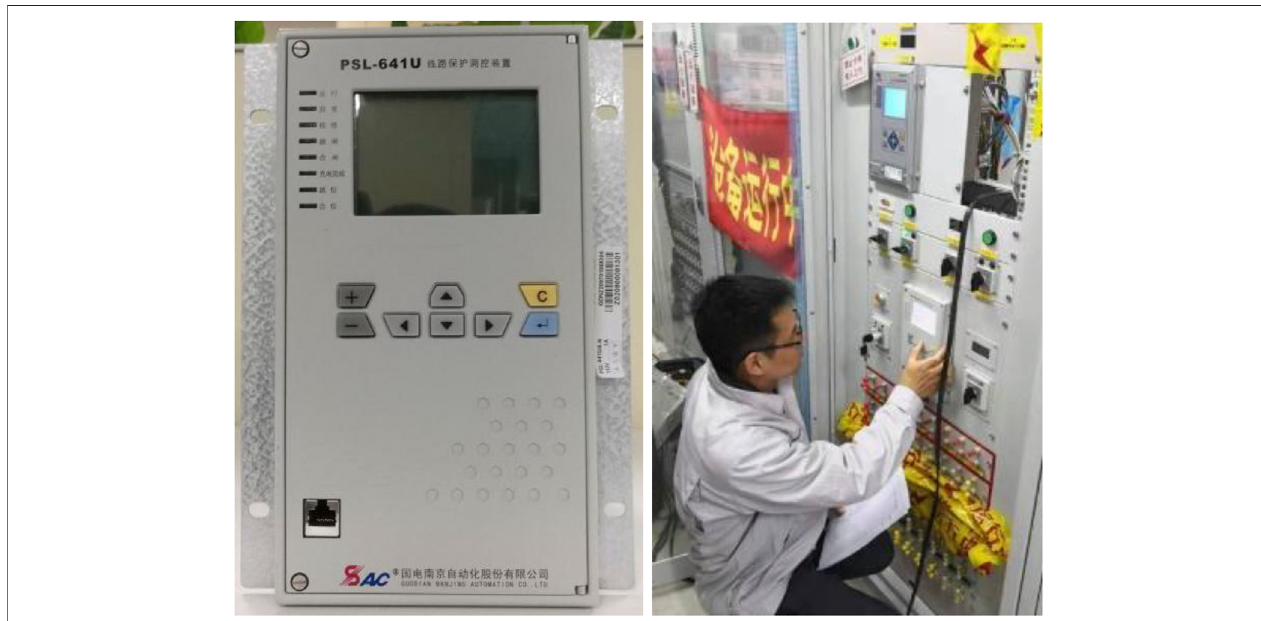
FIGURE 10 | The photos of distance protection device based on SoC chip special for power system and industrial fi eld testing.